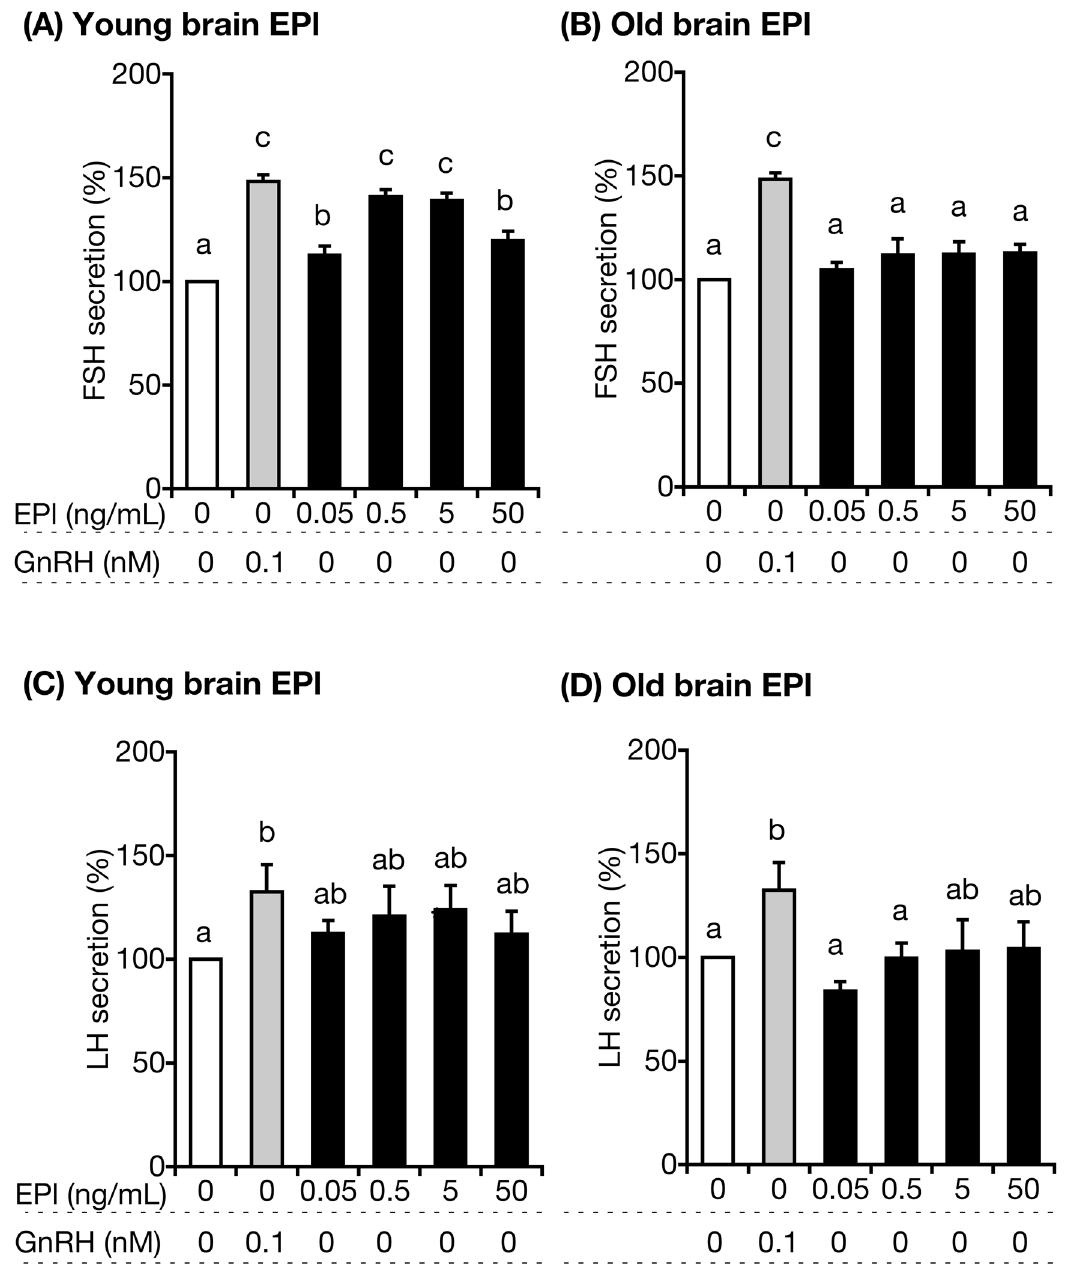
Figure 1. Effects of various concentrations of bovine brain EPl in media lacking GnRH on hormone secretion from cultured AP cells. EPl was obtained from fertile young heifers ( A , C ) and old cows ( B , D ), and its effect was tested on FSH ( A , B ) and LH ( C , D ) secretions. FSH and LH concentrations in control cells (cultured in medium lacking EPl and GnRH) were averaged and set as 100%. The mean FSH or LH concentrations in each treatment group were expressed as percentages of the control value. Bars labelled with different letters (a, b, and c) indicate different stimulatory effects ( P < 0.05; Details of P value are presented in Supplementary Tables S1– S4). The bars labelled with the same letter indicate a similar stimulatory effect. Statistical analysis was conducted using one-factor analysis of variance, followed by Fisher’s protected least significant difference test. AP anterior pituitary, EPl ethanolamine plasmalogen, GnRH gonadotropin-releasing hormone, FSH follicle-stimulating hormone, LH luteinising